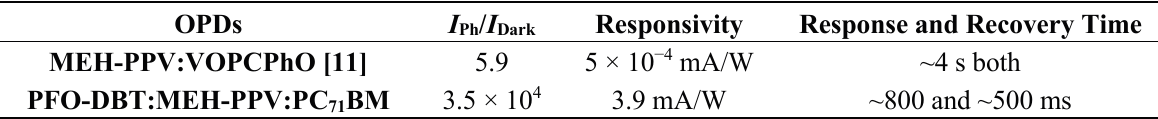
Table 1. Comparison of the sensor’s parameters at − 3 V biasing at 100 mW/cm 2 .